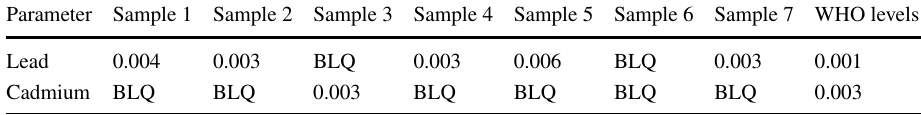
Table 4 The levels of heavy metal content in the hand-dug wells of Kakamega